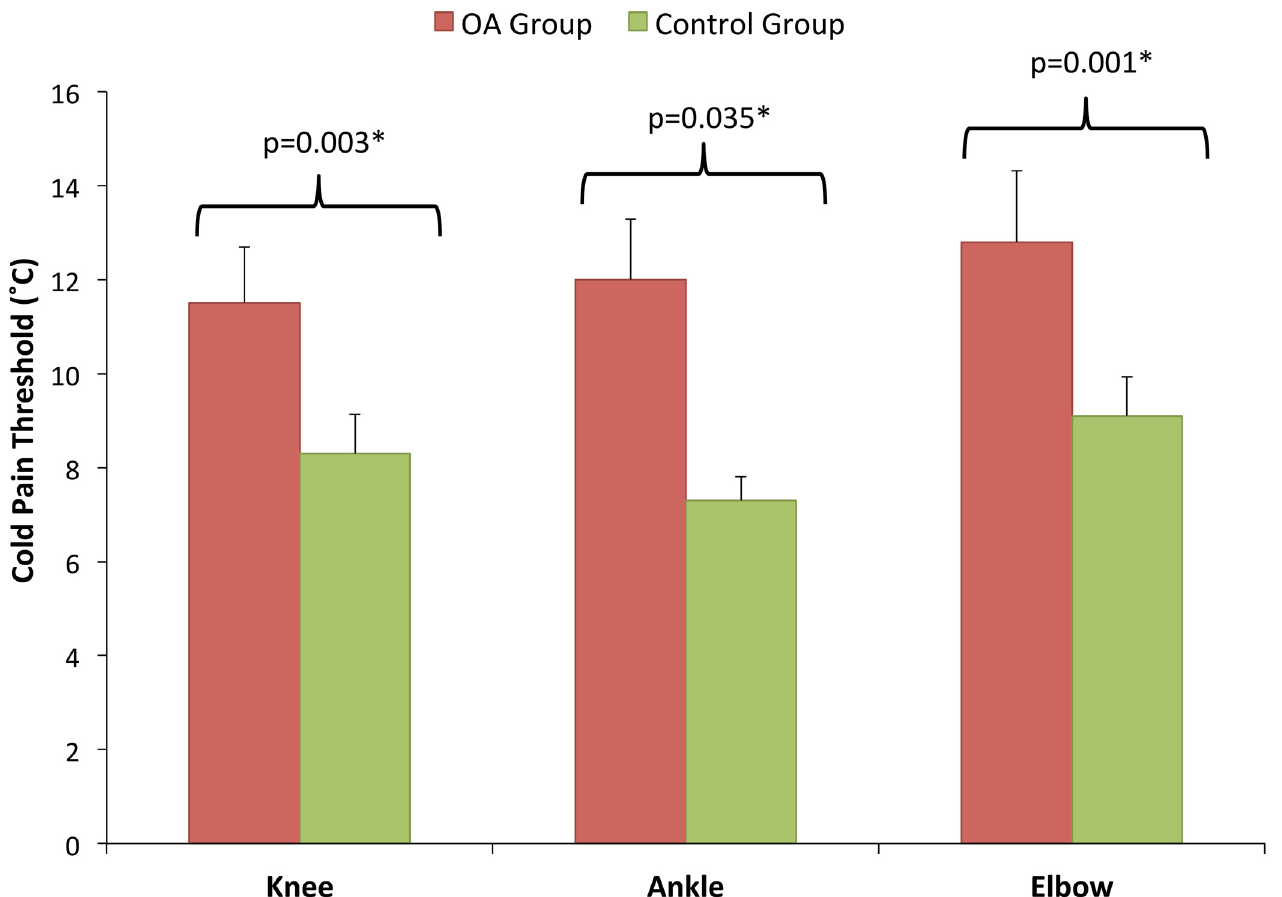
Fig 2. Cold Pain Threshold. There was a significant difference between OA and Control groups in cold pain thresholds at both local and distant sites.